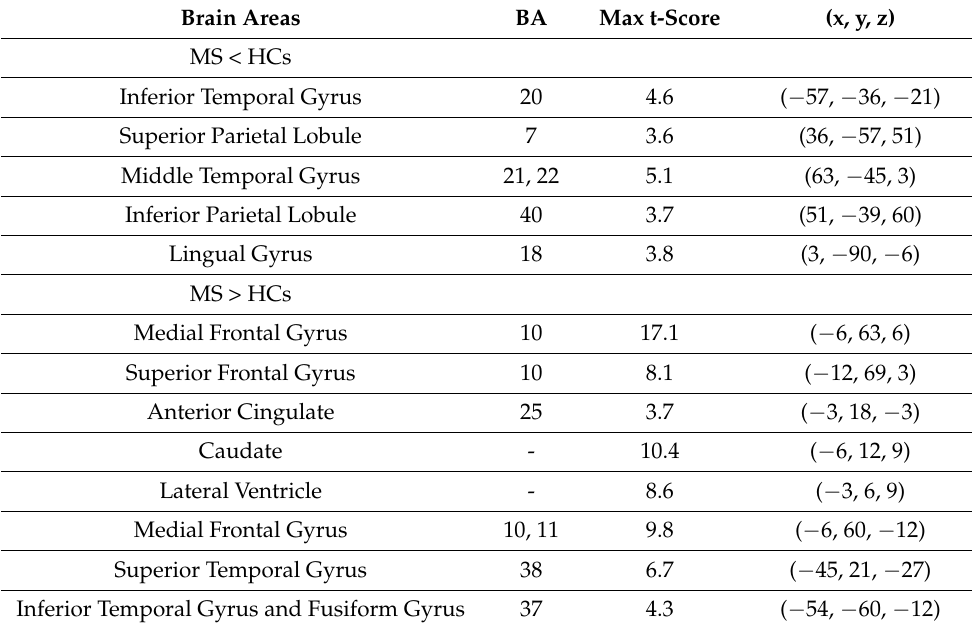
Table 2. MS and healthy group differences using